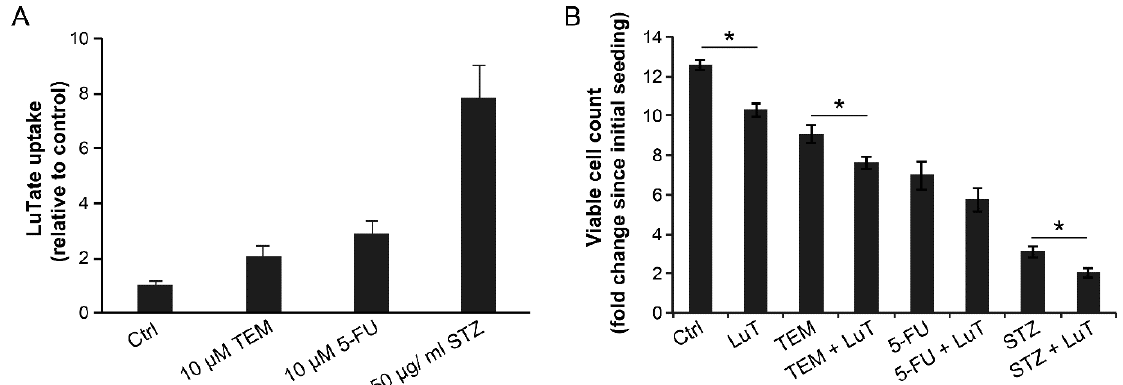
Figure 5. Improved LuTate uptake and growth suppression in BON-1 cells treated in sequence with chemotherapeutic drugs and LuTate. ( A ) LuTate uptake: BON-1 cells treated for 24 h with specified dose of three different drugs (or control) were allowed to recover in fresh medium for 4 days before exposure to LuTate for 4 h followed by processing for total cellular uptake of LuTate. The cells were seeded in triplicate and data derived from three independent experiments is presented as Mean ± SE. All three chemotherapy treatment groups had a statistically significant difference in LuTate uptake as compared to mock treated control. ( B ) Cell proliferation: An independent set of cells were treated with same regime but were allowed to recover for five days in fresh medium after removal of LuTate, and assessed for the fold increase in viable cell count to determine the rate of proliferation after initial seeding. The data derived from triplicates from two experiments are expressed as Mean ± SE. The * refers to a statistically significant difference ( p < 0.05). Cancers 2021 , 13 , x